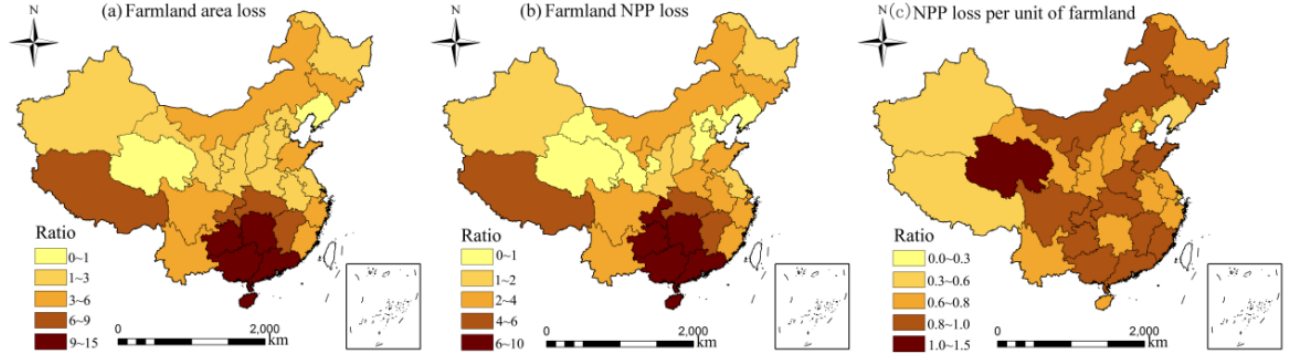
Figure 7. Ratios of farmland loss due to urban sprawl to the loss due to rural settlement expansion from 2000 to 2020.